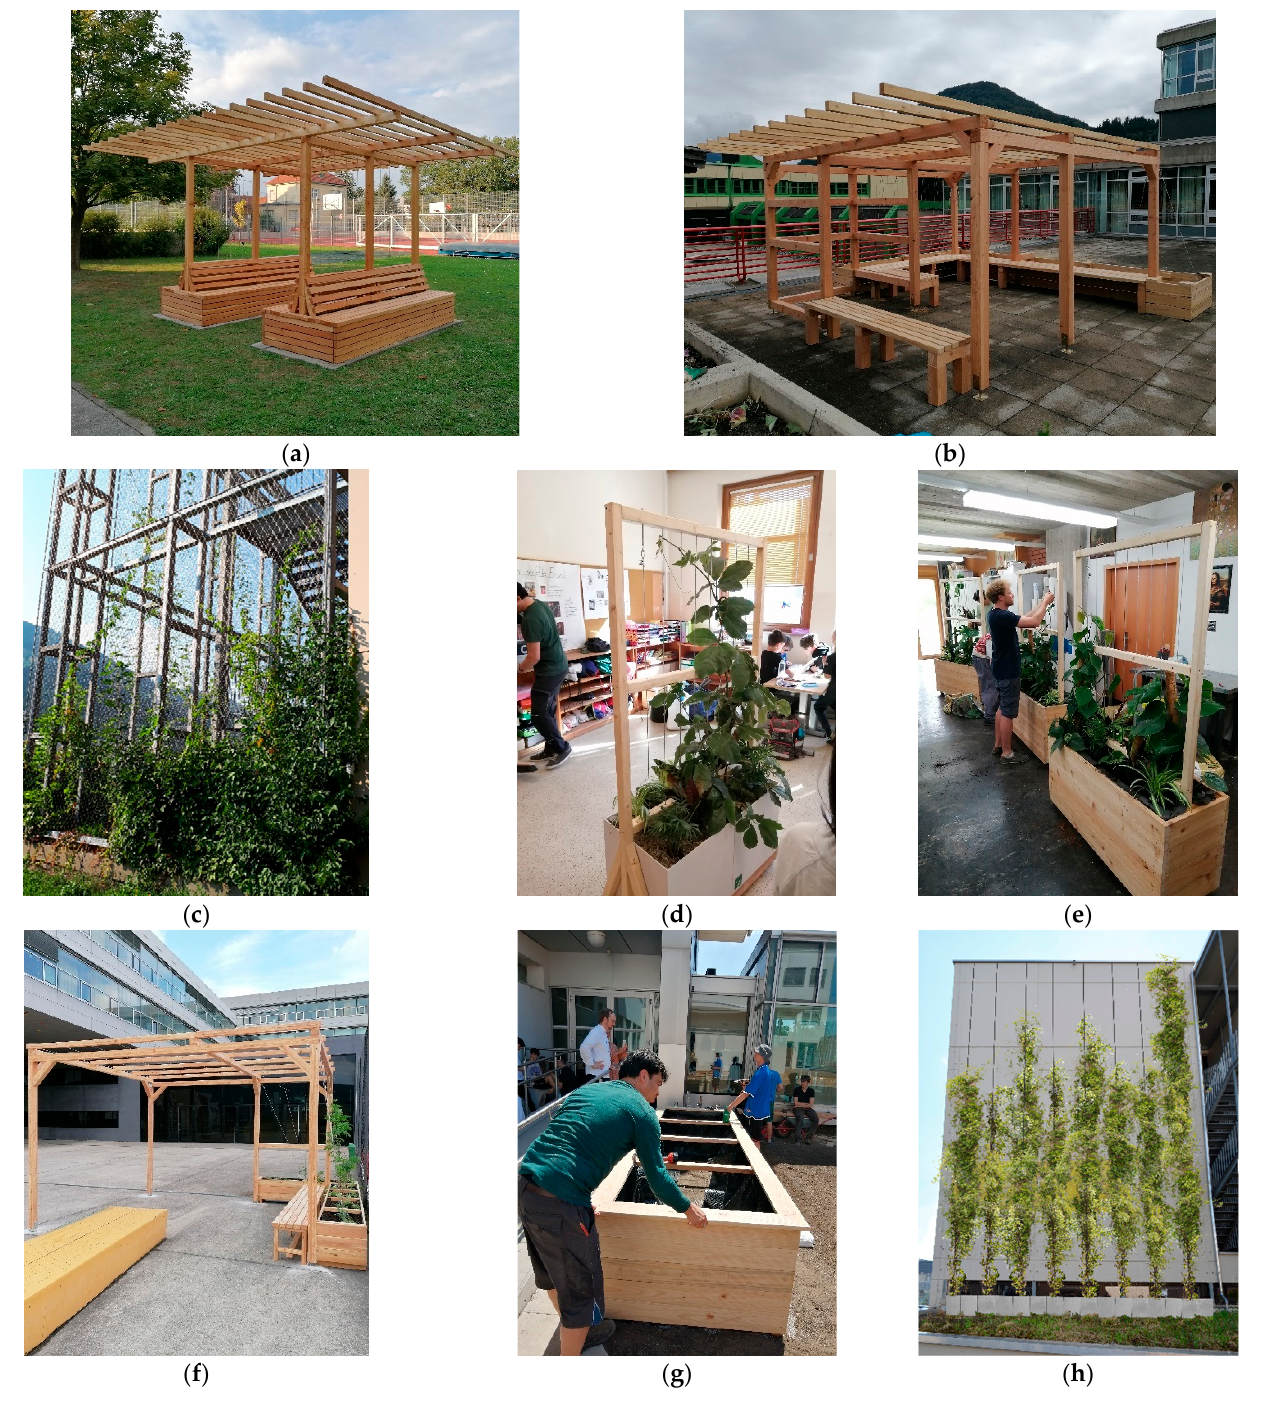
Figure 6. Results of the greening workshops in Austria’s provinces: ( a ) Korneuburg (Lower Austria)—pergola “T-Bench”; ( b ) Wörgl (Tyrol)—pergola “Green Classroom”; ( c ) St. Johann (Salzburg)—climbing plants; ( d ) Maria Gail (Carinthia)—mobile green wall; ( e ) Graz (Styria)—mobile green wall; ( f ) Kirchdorf (Upper Austria)—pergola “Green Classroom”; ( g ) Neusiedl (Burgenland)—raised bed; ( h ) Lauterach (Vorarlberg)—climbing plants.